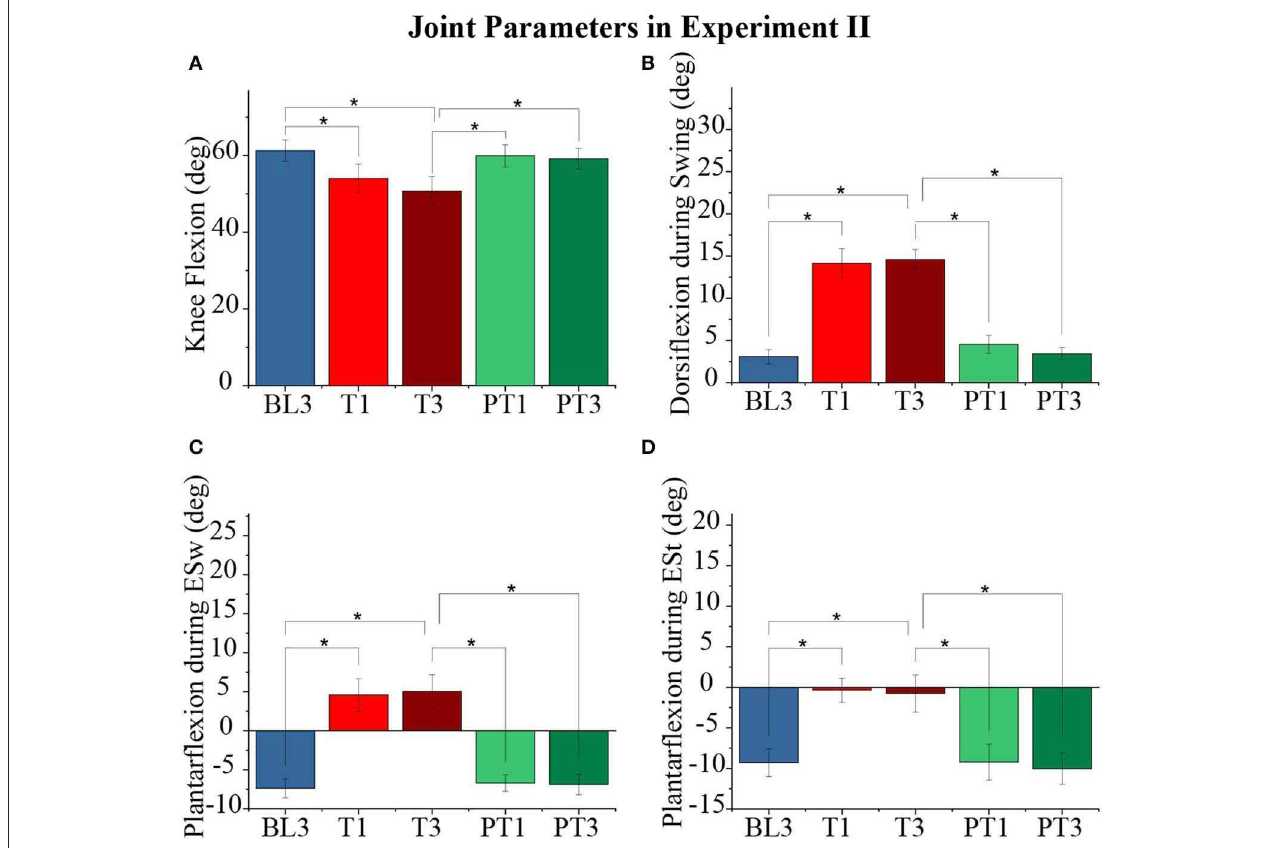
FIGURE 10 | (A) Knee Flexion values of the perturbed leg for different sessions. (B) Ankle dorsiflexion values of the perturbed leg during the swing for different sessions. (C) Ankle plantarflexion values of the perturbed leg during early swing (ESw) for different sessions. (D) Ankle plantarflexion values of the perturbed leg during early stance (ESt) for different sessions. The data presented here are averaged across all participants of the Experiment II with standard error (* p < 0.05).